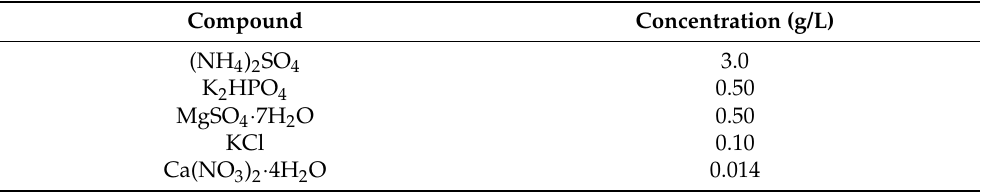
Table 1. Nutrient medium used in experiments ([20] without iron).